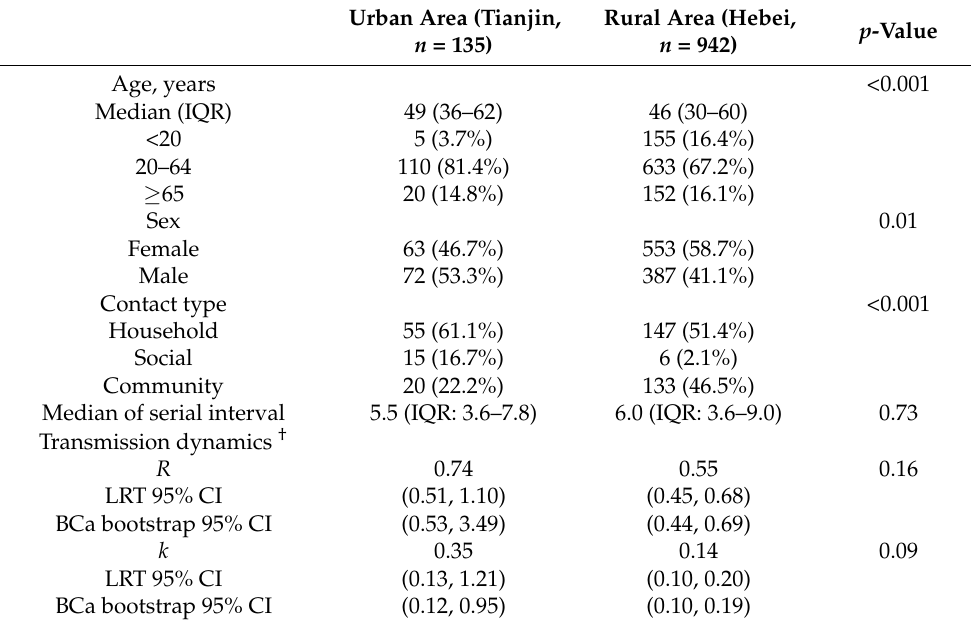
Table 1. Comparison of SARS-CoV-2 transmission between urban and rural areas.